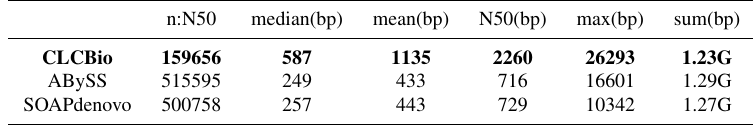
Supplementary Table 1: Carp genome assemblies produced by CLCBio, ABySS and SOAPdenovo.